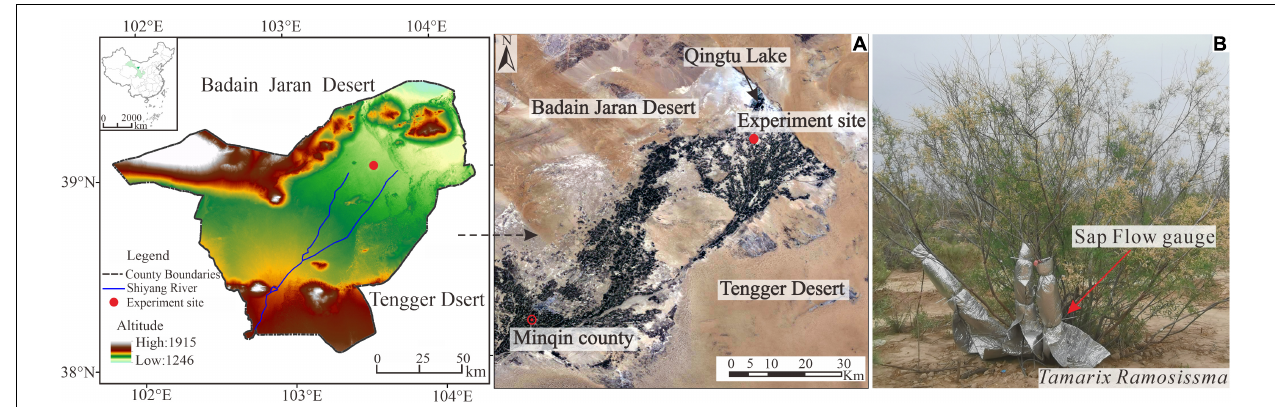
FIGURE 1 | The location of the experiment site in the desert-oasis transition zone in Minqin, China (A) and the representative Tamarix ramosissima ( T . ramosissima ) shrubs and the equipment for the stem sap flow (SSF) measurements (B) . Modified from Pan J. et al. (2020).